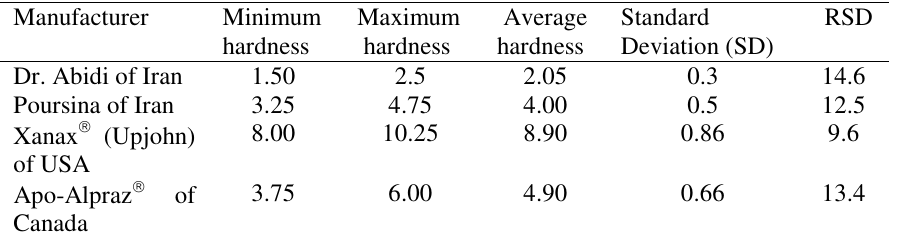
Table 1 . Results obtained from the hardness test of alprazolam tablets (in Kg/cm 2 ) Manufacturer